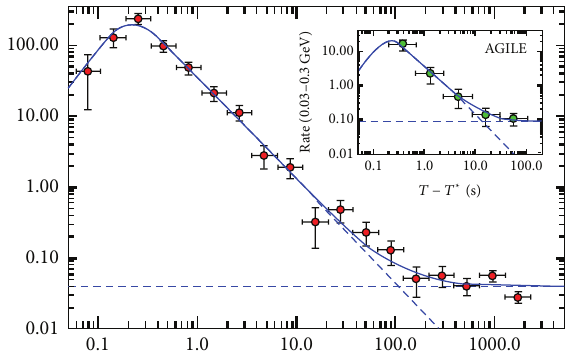
Figure10:LightcurveoftheemissionofGRB090510above100 MeV extends to > 100s and can be fitted with a smoothly broken power law.Thetimesarescaledtothetime 𝑇 ⋆ = 0 . 6 saftertheGBMtrigger. The inset shows the AGILE light curve (energy range 30–300 MeV), extending to much shorter times. Figure taken from Ghirlanda et al.